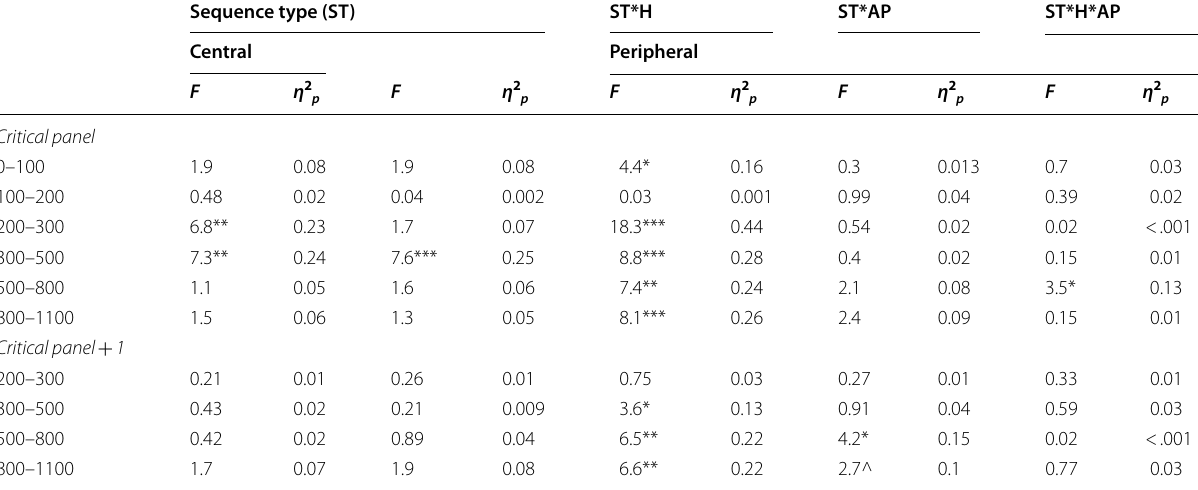
ST sequence type, H hemisphere, AP anterior–posterior